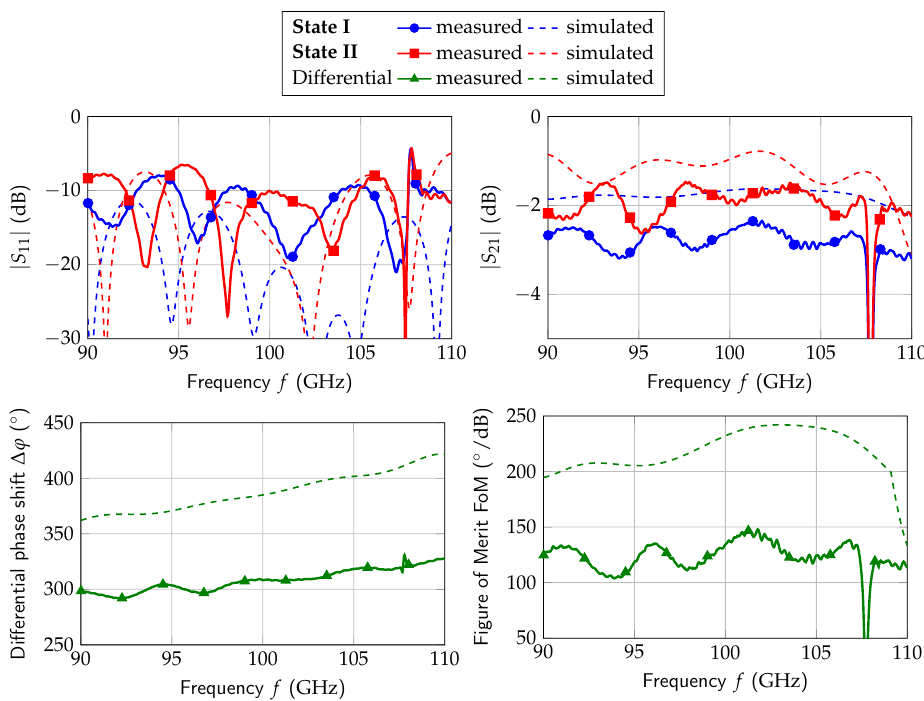
Figure 17. Measured (solid) and simulated (dashed) results of the magnetically biased W-band rectangular waveguide phase shifter based on LC.